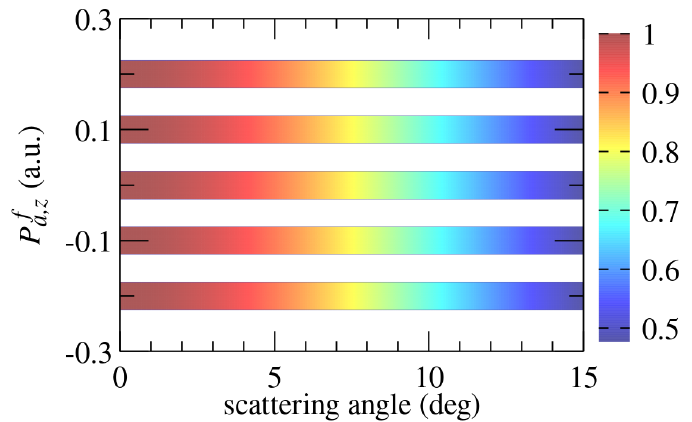
Figure 2. The differential cross-section for the elastic scattering of 300 eV electrons incident along the x axis on Xe atoms ( P i a = 100 a.u.) passed through a diffraction grating with a = b = d /2 = 0.1 mm and N 0 = 5. D = 200 mm. The cross-section is given in relative units with its intensity ranging from 0.5 to 1. (The blank regions correspond to zero cross-section